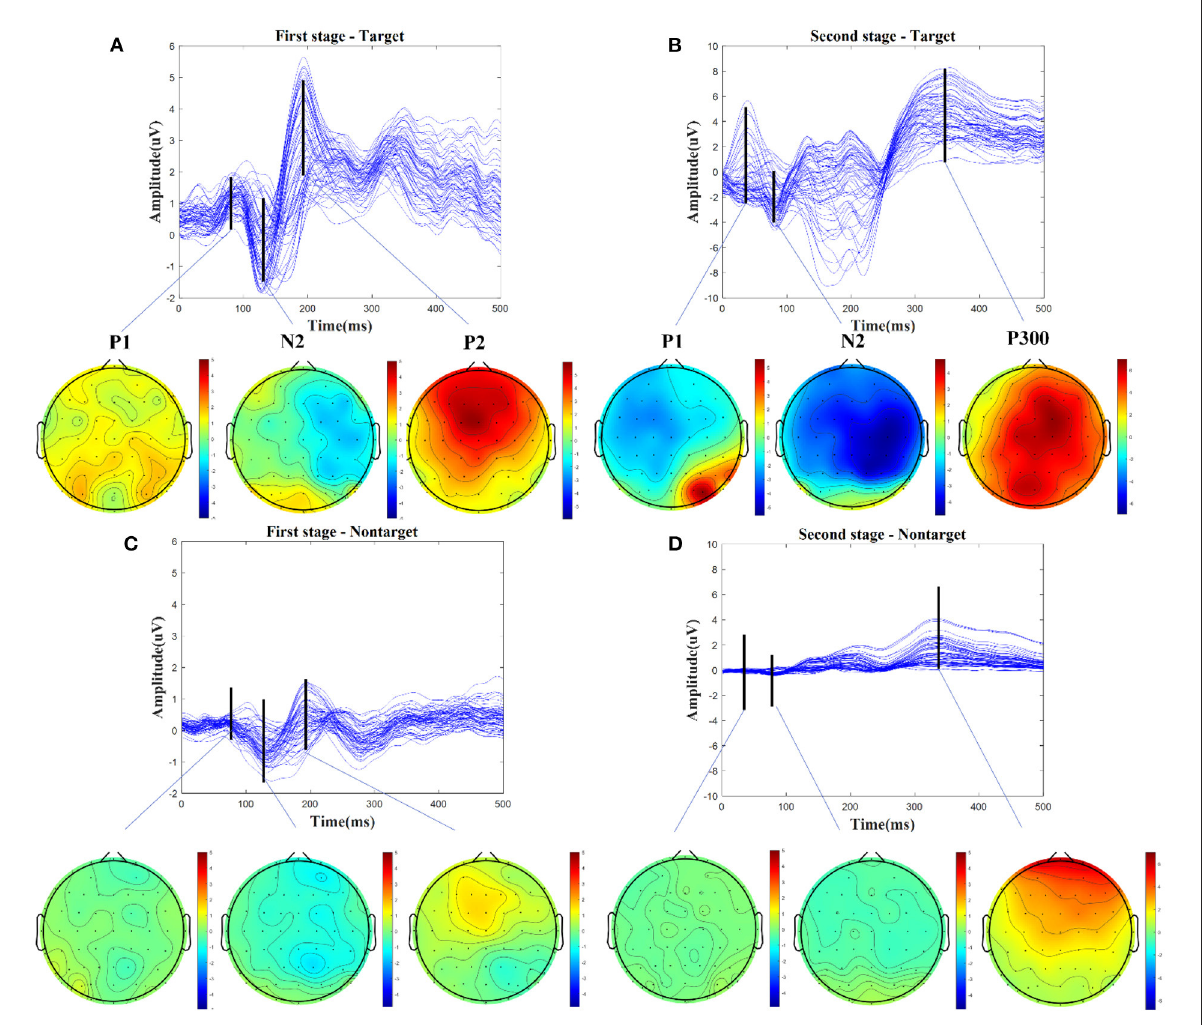
FIGURE3 Averaged scalp potentials on 62 channels and topographies from the target and nontarget EEG epochs, for one example subject S10. (A) The mVEP components of P1, N2, and P2 and their topographies are in the first stage. (B) The audio-assisted visual evoked components of P1, N2, and P300 and their topographies are in the second stage. (C) The nontarget-related signal and topographies are in the first stage. (D) The nontarget-related signal and topographies are in the second